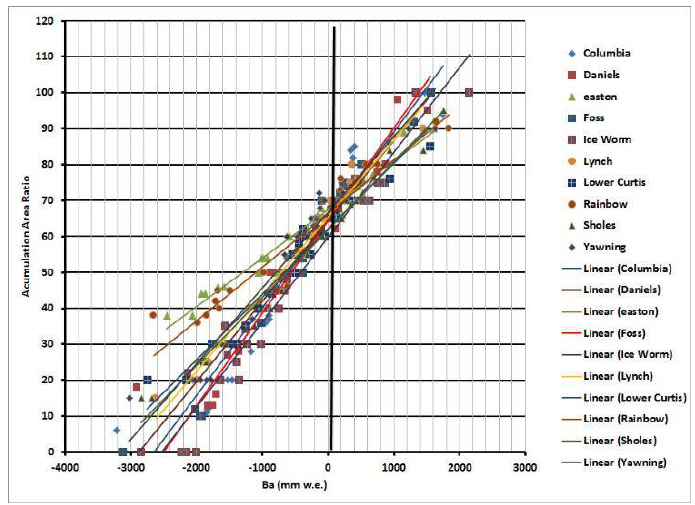
Figure 3. Relationship between annual balance and accumulation are a ration on the North Cascade glaciers.